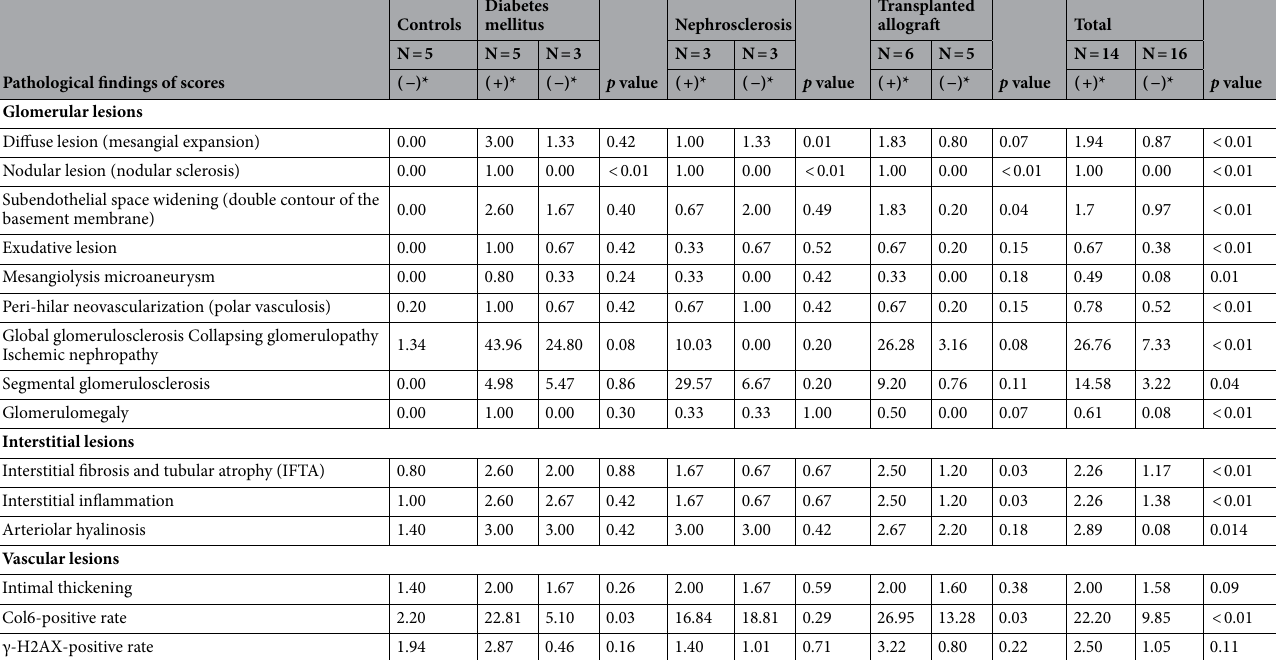
Table 2. Pathological findings in subgroups by glomerular nodular lesions. Comparisons between groups were evaluated by the Mann–Whitney U test. *Nodular lesions.